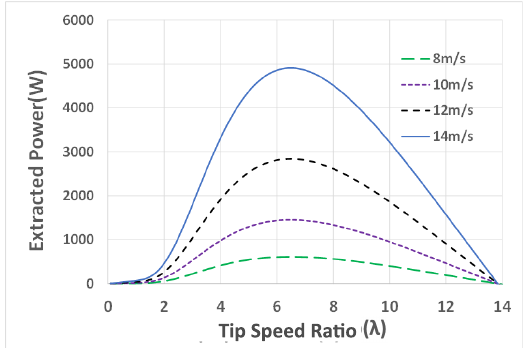
Figure 2. Extracted power P m vs. tip speed ratio Λ at varying wind